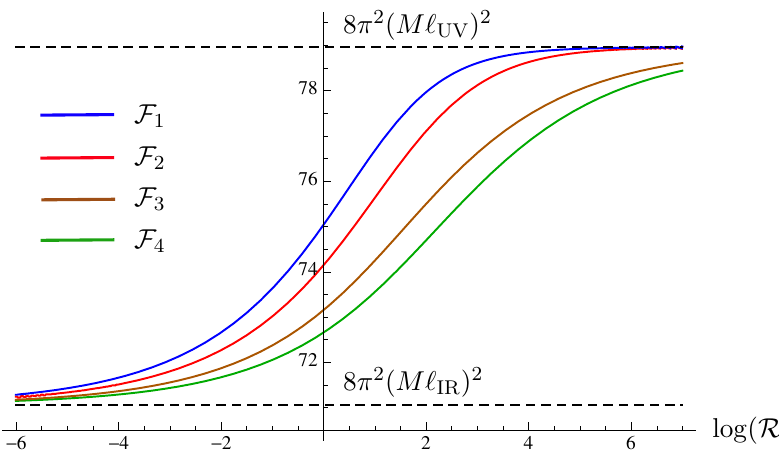
Figure 2. F -functions F 1 ; 2 ; 3 ; 4 de(cid:12)ned in (1.21){(1.24) vs. log( R ) for a holographic model with dilaton potential (4.31) and (cid:1) (cid:0) = 1 : 2.